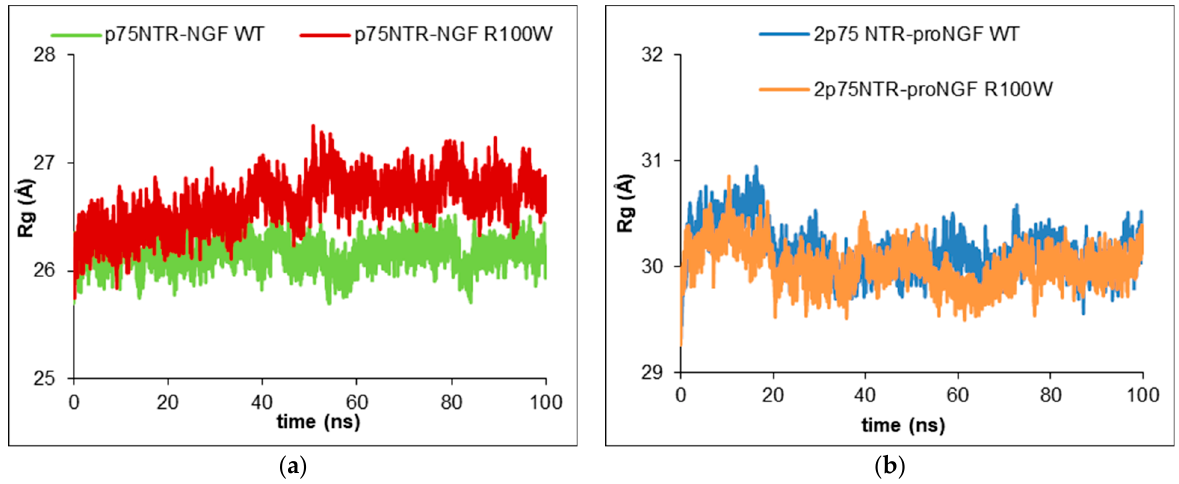
Figure 3. Radius of gyration plots of the complexes: ( a ) p75NTR/NGF and ( b ) 2p75NTR/proNGF. A similar opposite behaviour can be observed comparing the COM-COM distances of the WT and R100W mutants in the p75NTR/NGF and 2p75NTR/proNGF complexes (Figure 4). Indeed, the COM-COM distances of the p75NTR/NGF WT complex became smaller during the simulation, with small variations and a mean value of 18.38 ± 0.75 Å, which is significantly lower than the mean COM-COM distances of the complex between p75NTR and NGF R100W (i.e., 20.16 ± 0.58 Å), whose profile shows remarkable oscillations (Figure 4a). Instead, the COM-COM distances in the p75NTR/proNGF complexes show similar behaviours for the WT and the R100W mutant, with there being mean values of 18.78 ± 0.83 Å and 18.55 ± 0.56 Å between the chain X of p75NTR and proNGF WT and R100W, respectively, and 18.59 ± 0.52 Å and 19.16 ± 0.50 Å between the chain Y of p75NTR and proNGF WT and R100W, respectively. It is also interesting to note that the fluctuations shown in the COM-COM distances between proNGF WT and both chains of p75NTR (Figure 4b,c) seem to be slightly more pronounced compared to those of the proNGF R100W